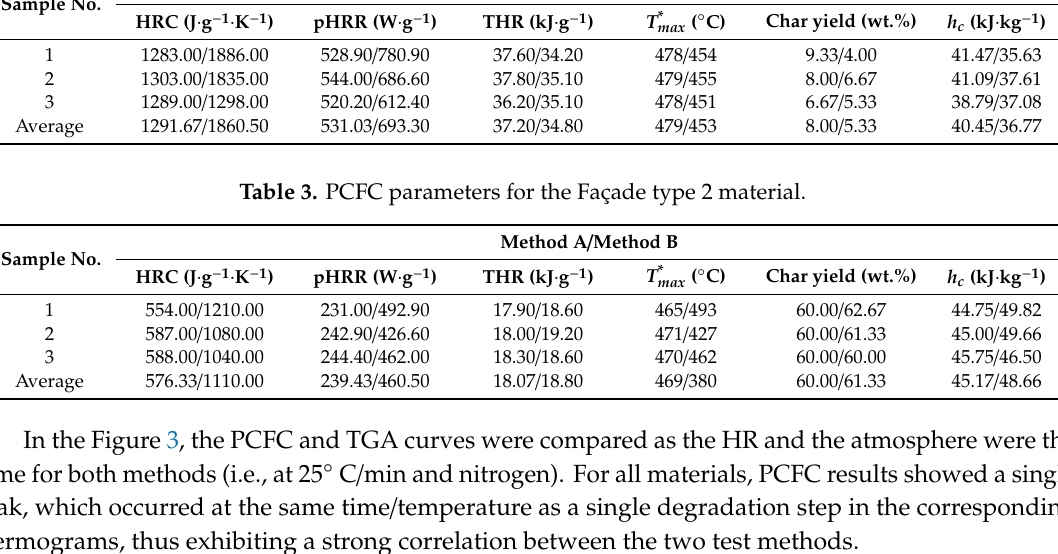
Table 2. Pyrolysis combustion flow calorimetry (PCFC) parameters for the Façade type 1 material. Sample No.